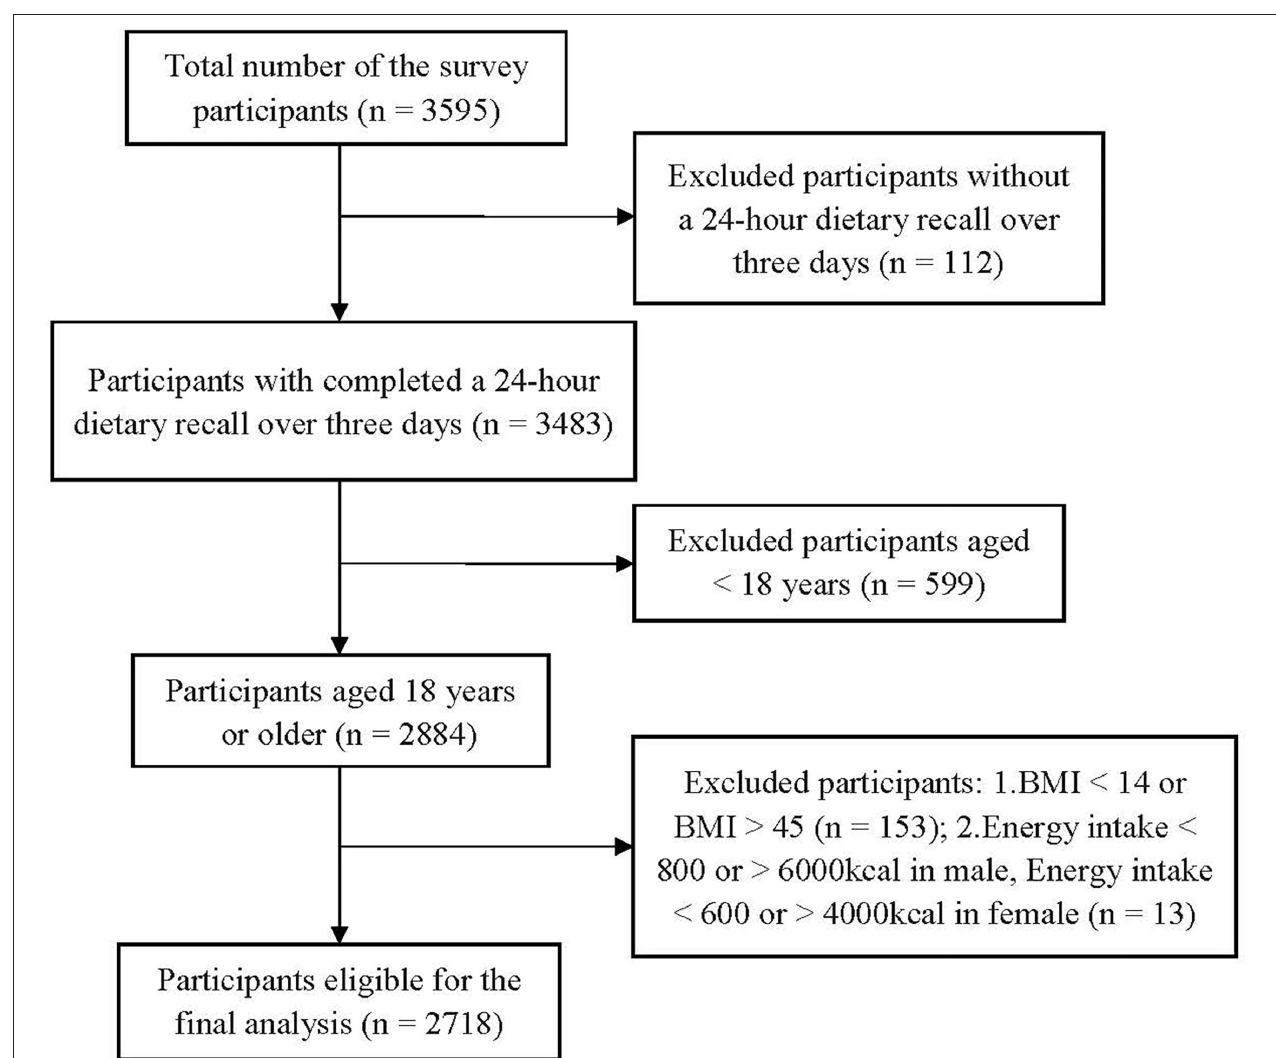
FIGURE 1 | Flowchart of study